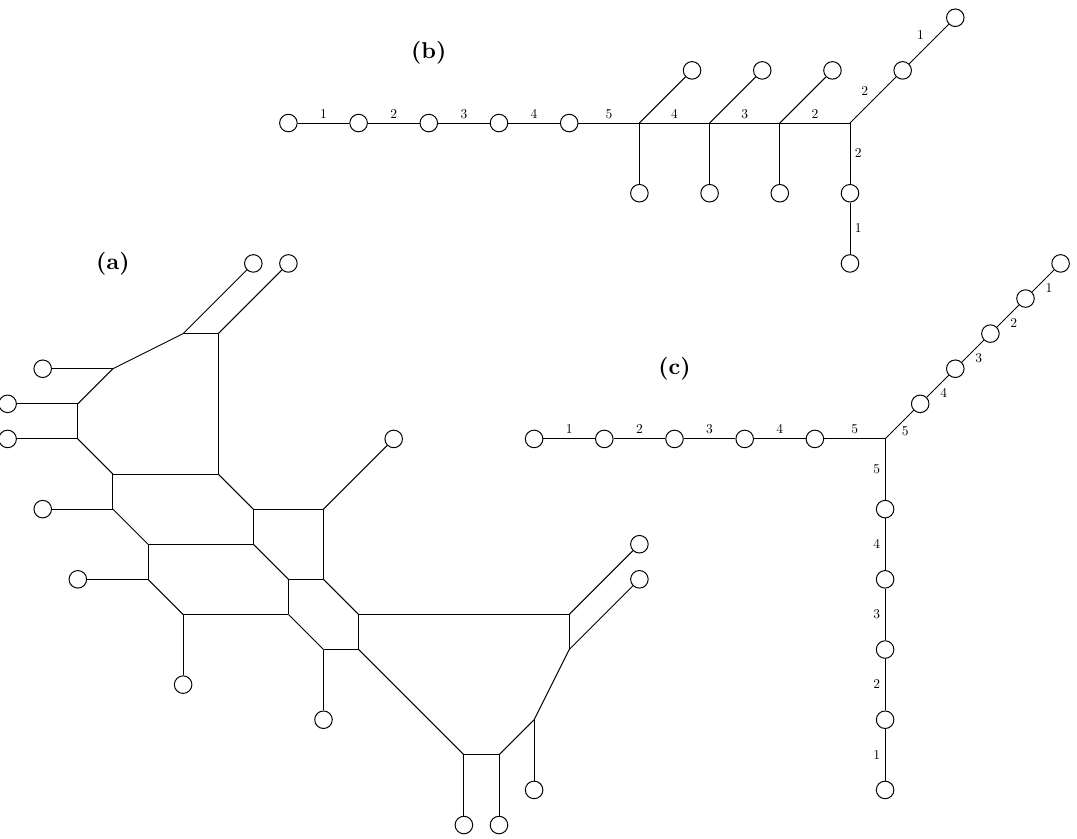
Figure 22 . Brane web for T 5 at (a) a general point on the extended Coulomb branch, (b) in the weakly coupled quiver description and (c) at the superconformal (cid:12)xed